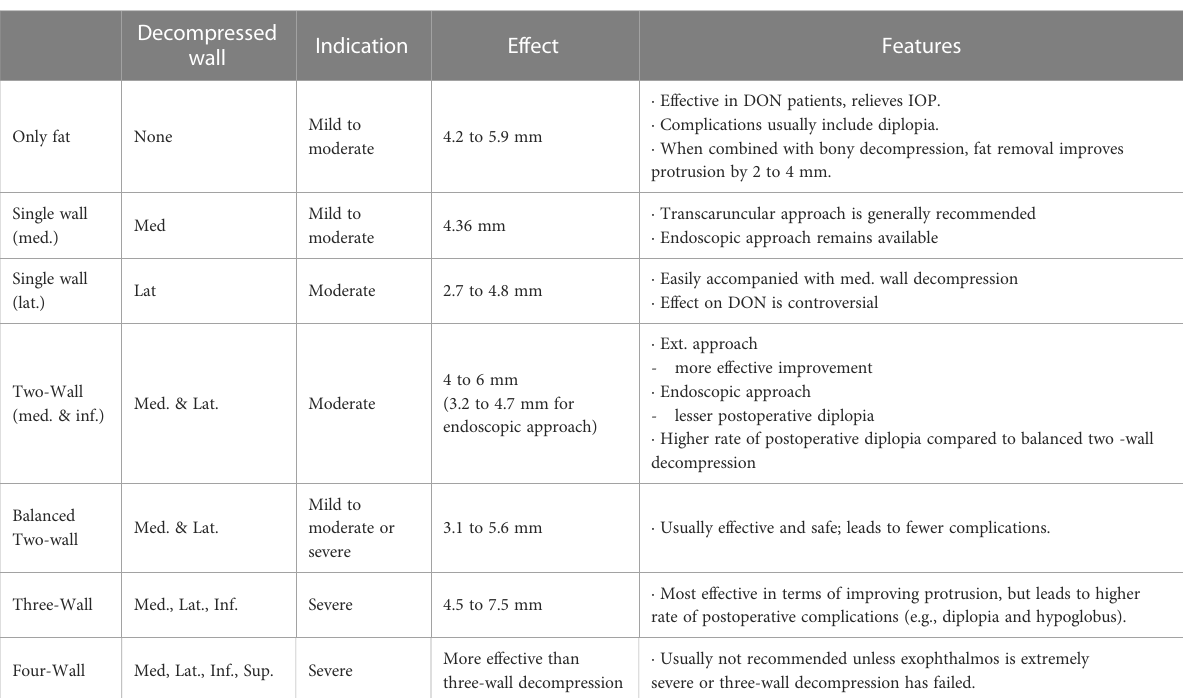
TABLE 1 Types of